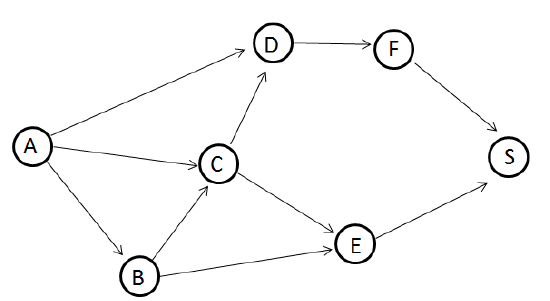
Fig. 2 Assumed Network model for I-XLP, directed Acyclic